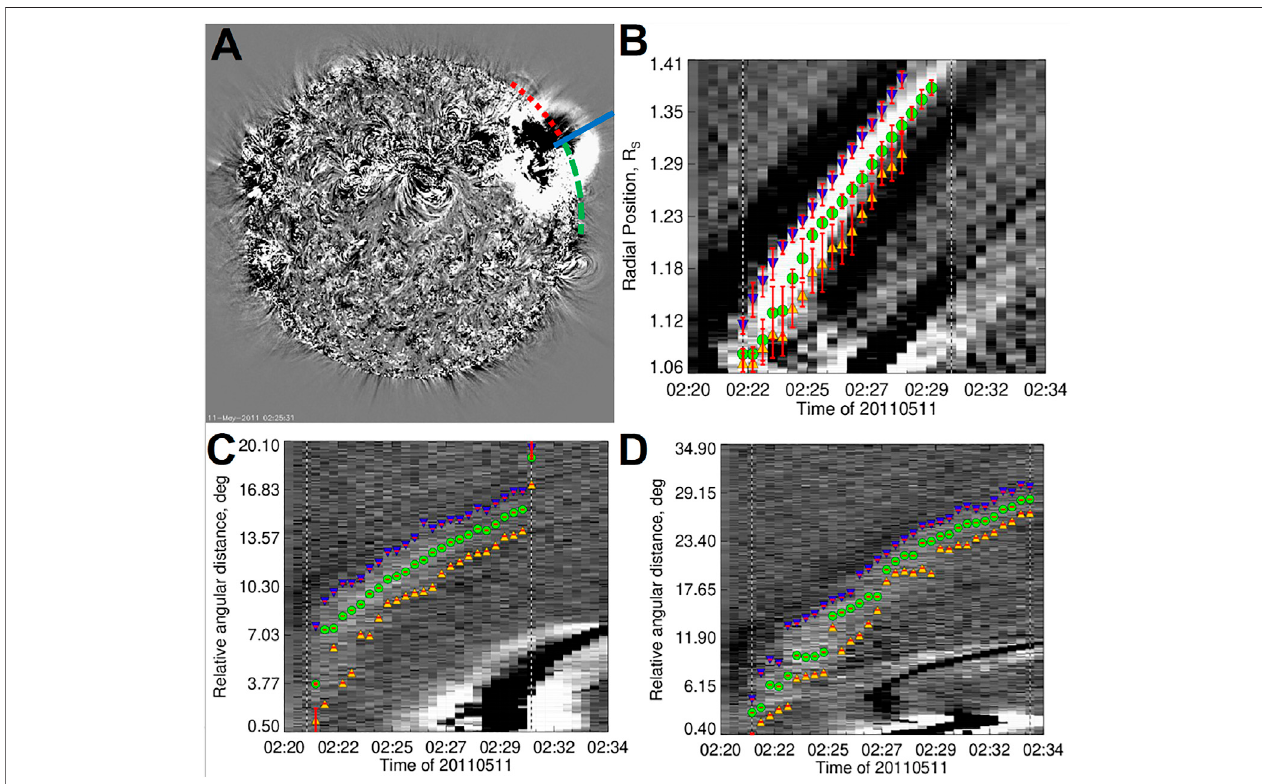
FIGURE 1 | Overview of the kinematics measurements for the May 11, 2011 event. (A) Global SDO/AIA 193 channel base difference image, showing clearly the CBFinmid-eruption.Theradialmeasurementdirectionisshownasabluesolidline.Thetwolateraldirectionsareshownasred/greendotted/dashedarcs. (B) Theradial kinematic measurements, including the J-map and the CBF average front, peak, and back positions. (C) The northward kinematic measurements, including the J-map and the CBF average front, peak, and back positions. (D) The southward kinematic measurements and J-map.